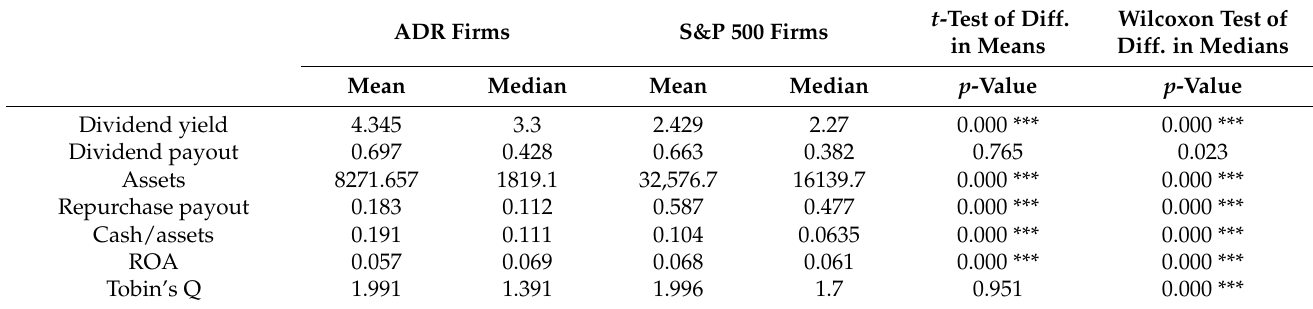
Table 2. Univariate